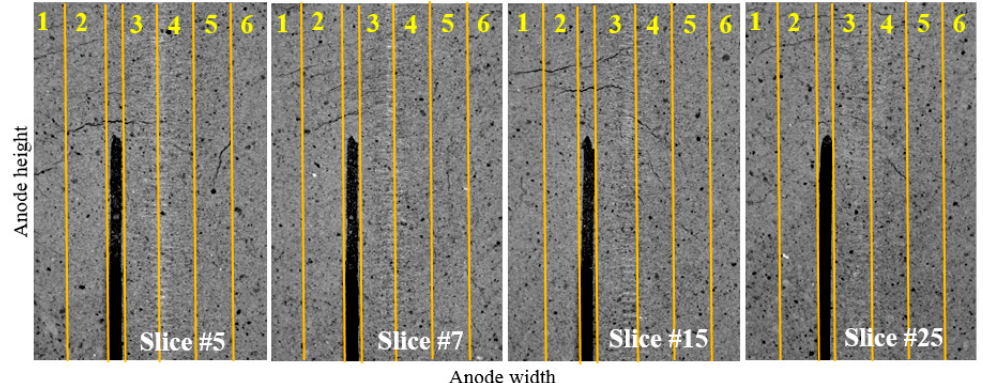
Figure 7. X ‐ ray images showing the distribution of cracks and pores through different corridors for selected anode slices.